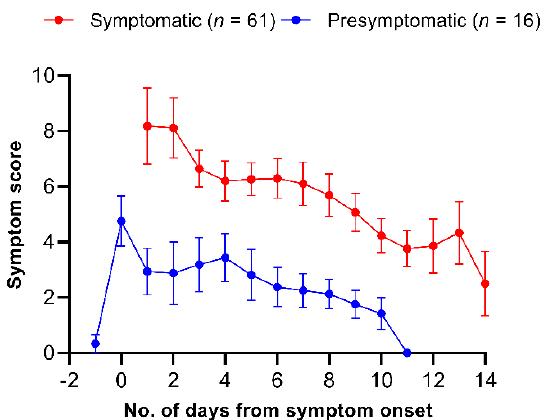
Figure 1. Summary curves of total symptoms scores in symptomatic and presymptomatic patients.